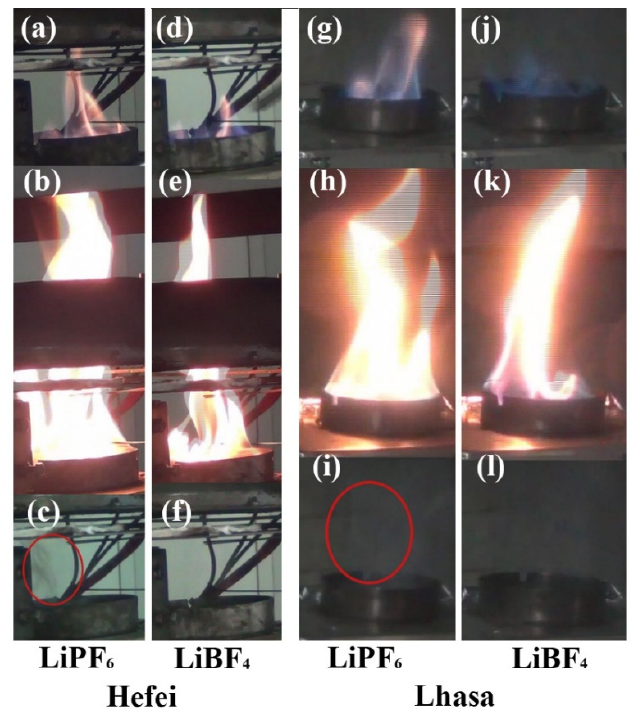
Figure 3. Combustion processes of the two samples in Hefei ( a – f ) and Lhasa ( g – l